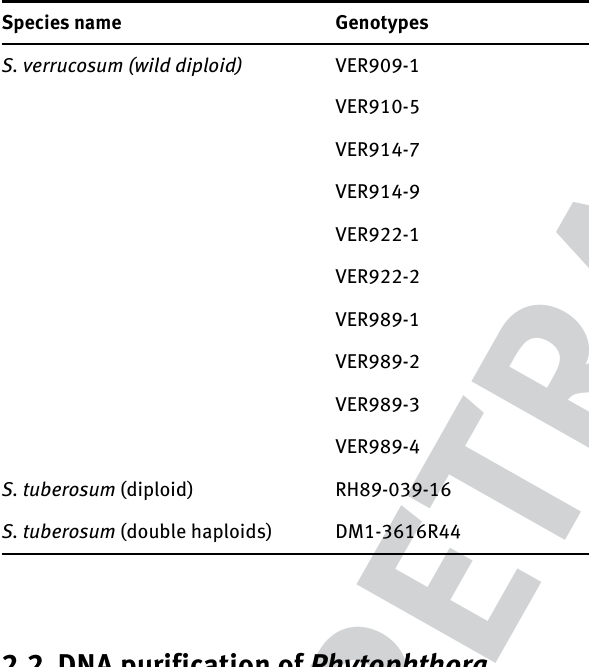
Table 2. List of Solanum tuberosum genotypes used for experiments